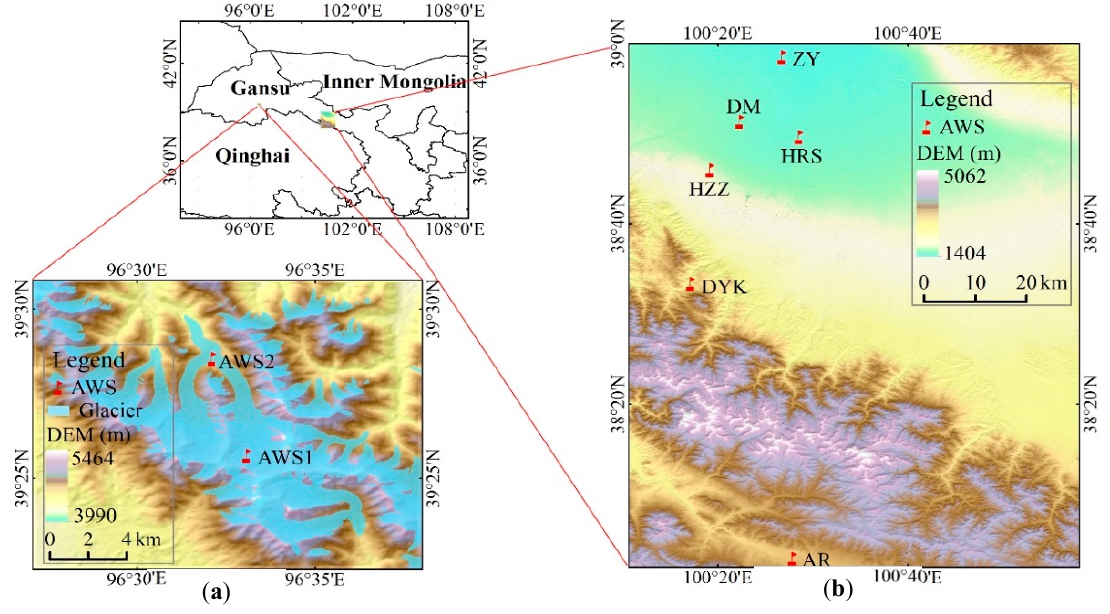
Figure 1. Overview of the study area: ( a ) the LHG of Qilian Mountain; ( b ) the UM-HRB. The LHG is located on the northern slope of the western end of the Qilian Mountains in Subei Mongolian Autonomous County, Gansu Province. This region is located at a high